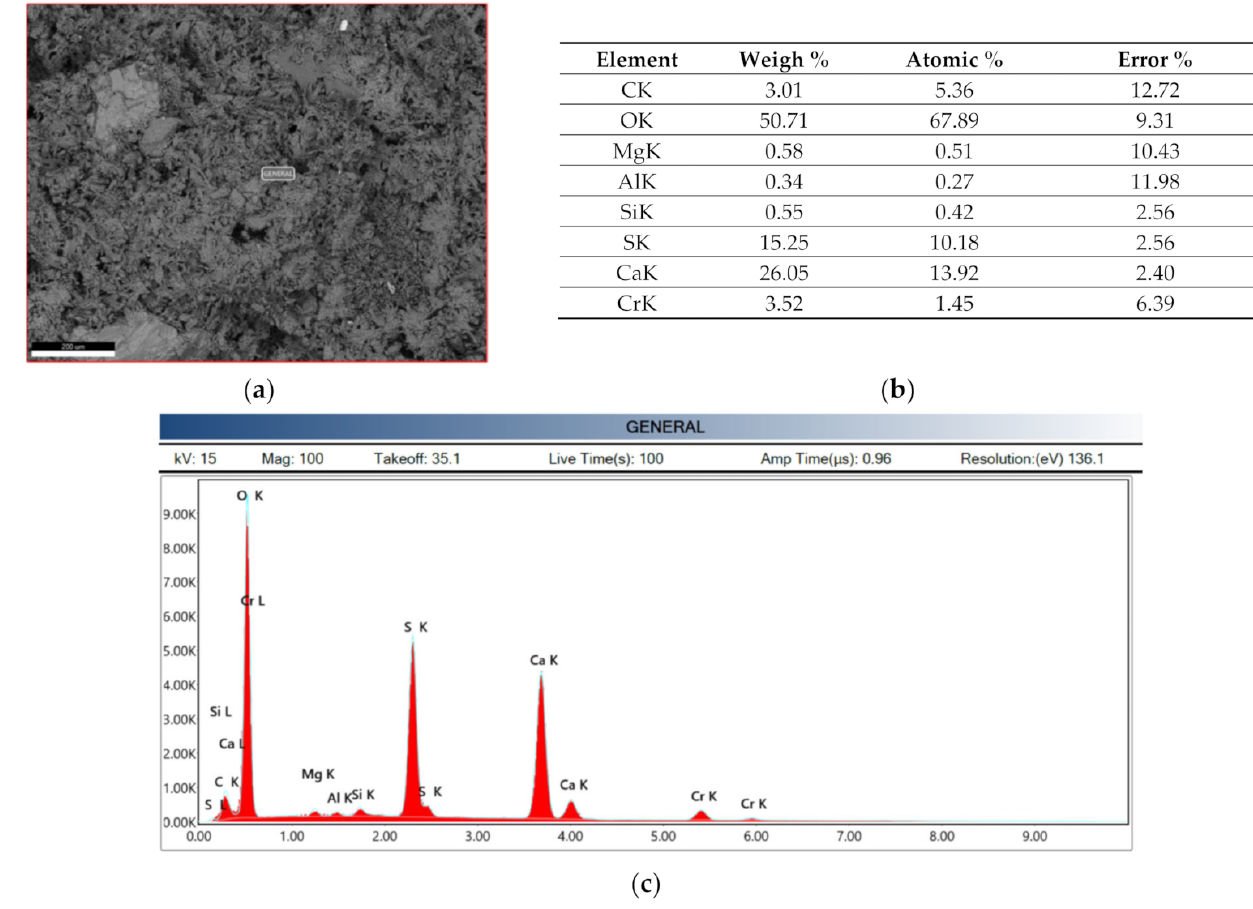
Figure 22. Analysis area and results for the compound containing calcium sulfate with polycarboxylate. Showing the general sample area and X-ray spectrograph (source: the author): ( a ) micrograph of gypsum with policarboxylate; ( b ) chemical composition; ( c ) chemical composition of gypsum with